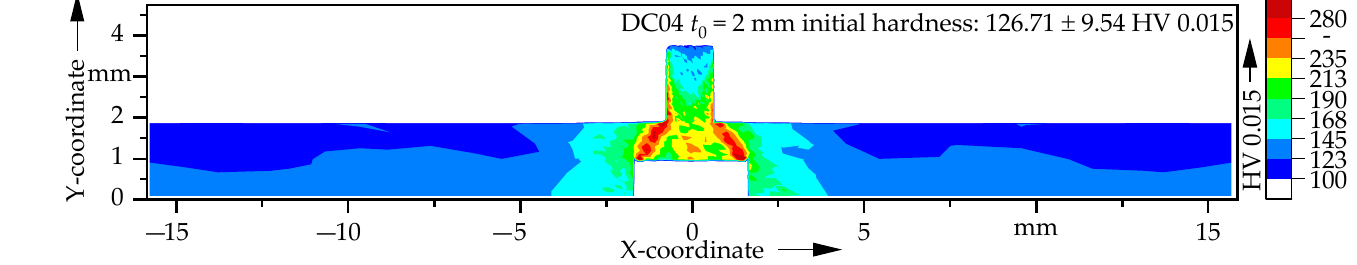
Figure 4. Hardness distribution of a pin structure extruded from the conventional DC04 sheet with a sheet thickness t 0 = 2 mm. sheet thickness t 0 = 2